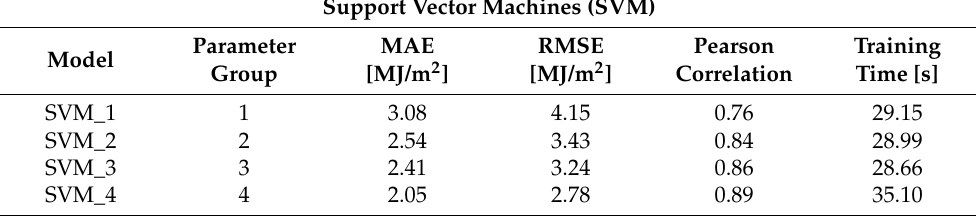
Table 4. SVM forecasting